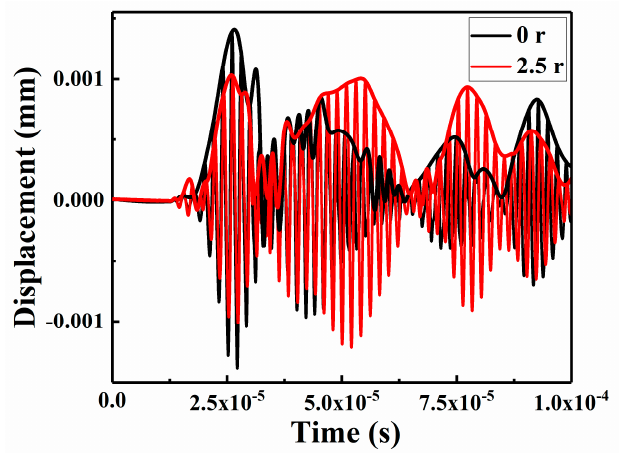
Figure 10. Numerical Lamb wave time-domain signal responses and envelopes. The envelope signal amplitude of the specimen repaired with a patch radius of 2.5 r was smaller than that of the unrepaired specimens, which might be due to the reduction